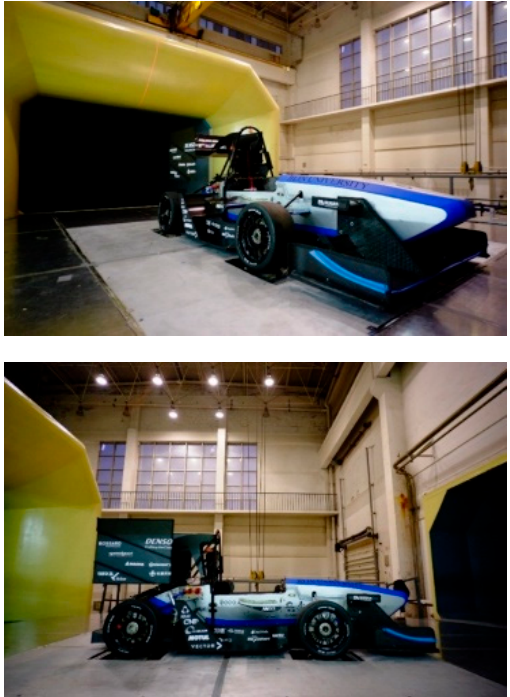
Figure 5. FSAE racing car of Jilin University. First, the aerodynamic six-component force of the FSAE racing car was measured under linear conditions. The wind velocity was set to increase from 15 to 30 m/s, with an increment of 5 m/s, and the air density was 1.18415 kg/m 3 . The test results are shown in Figure 6. With the increase of wind velocity, aerodynamic downforce and aerodynamic drag of the car continued to increase, and the lift-drag ratio of the vehicle basically re- mained unchanged.